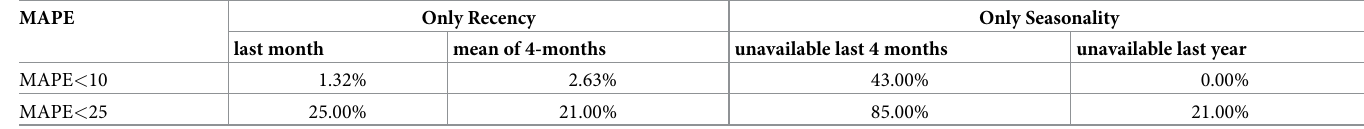
Table 12. Scarcity in seasonal historical and recent data—Evaluating performance of recency and seasonality features in 76 national parks in U.S. MAPE